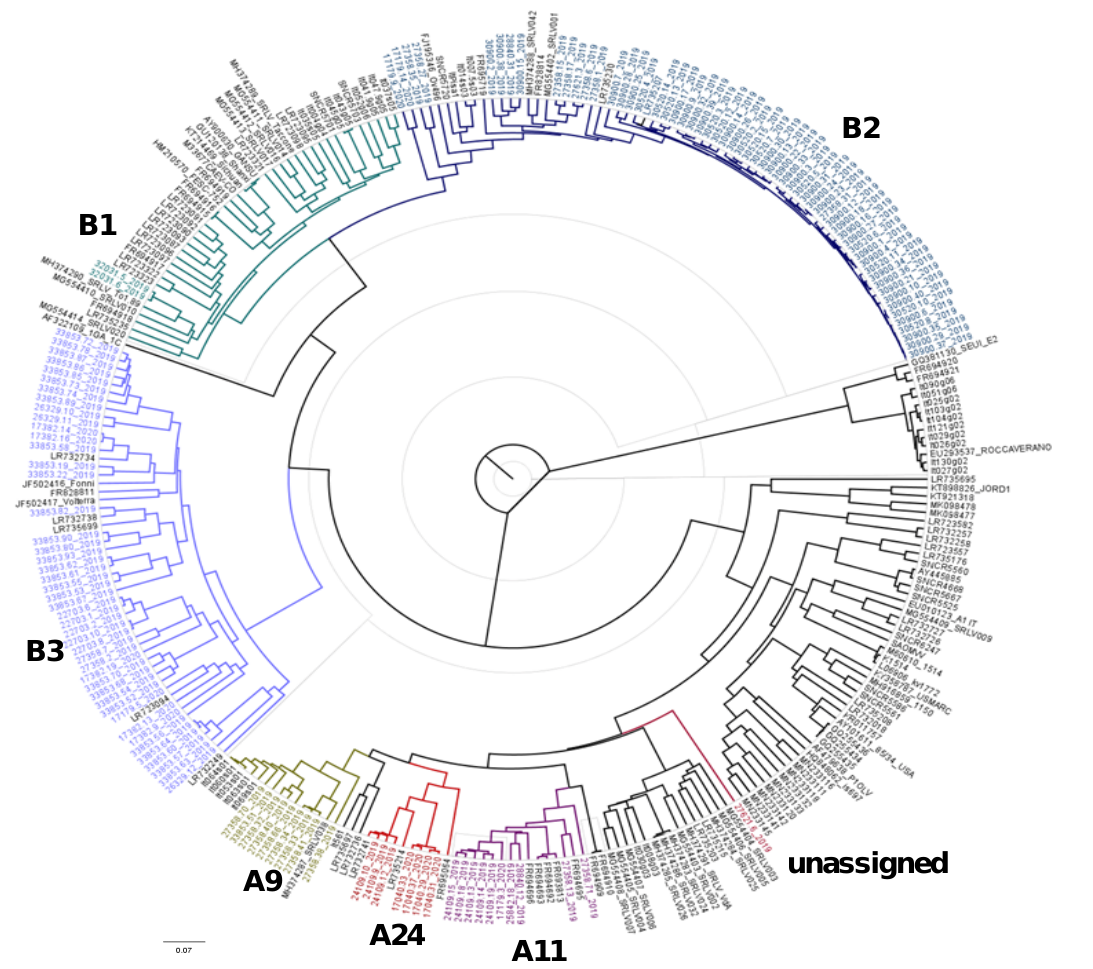
Figure 1. Maximum likelihood phylogenetic tree based on the alignment of 642 nt from gag-pol region of 287 sequences: 133 analysed in this study (labeled by a different color for each subtype) and 154 reference strains available in GenBank (labeled by black color). Bar: number of substitutions per site. Correspondence between sample names and accession numbers are reported in Table